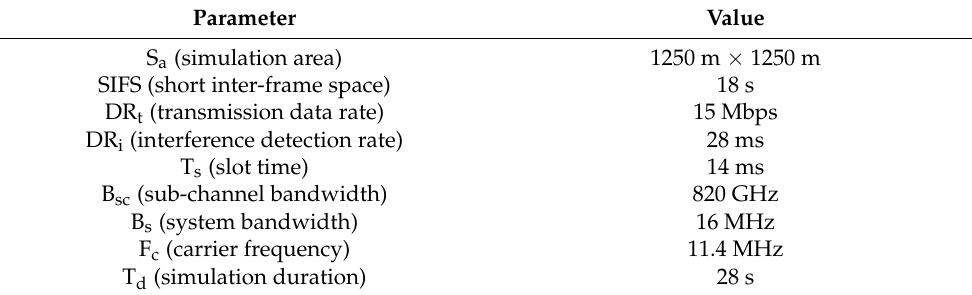
Table 2. Simulation